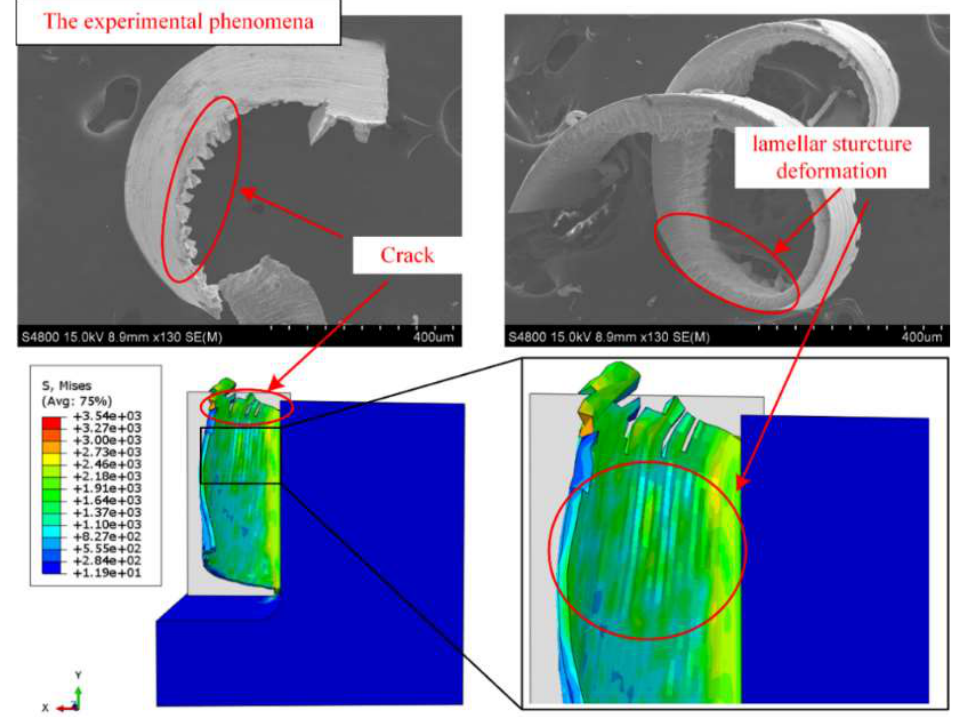
Figure 10. Cracks and lamellar structure were found in experiments and simulations.